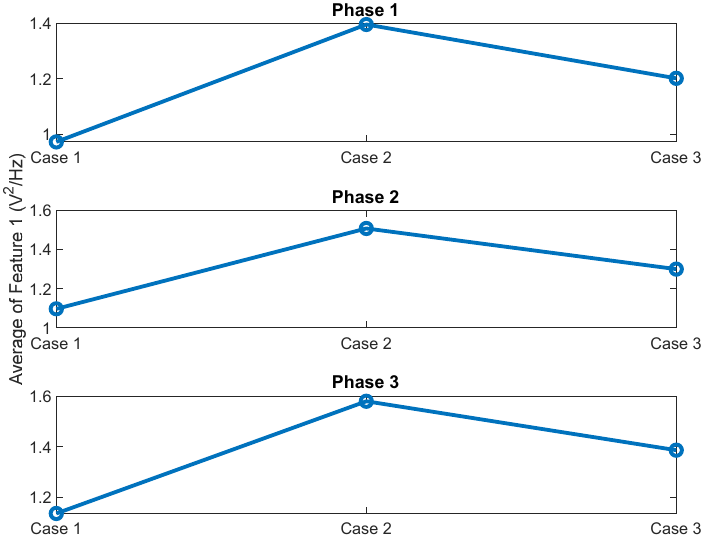
Figure 18. Average of Feature 1 for the three phases for the standard oil level for current signals, captured under different load conditions; Case1: no-load, Case2: 20 kg load (Day1) and Case 3: 20 kg load (Day2).